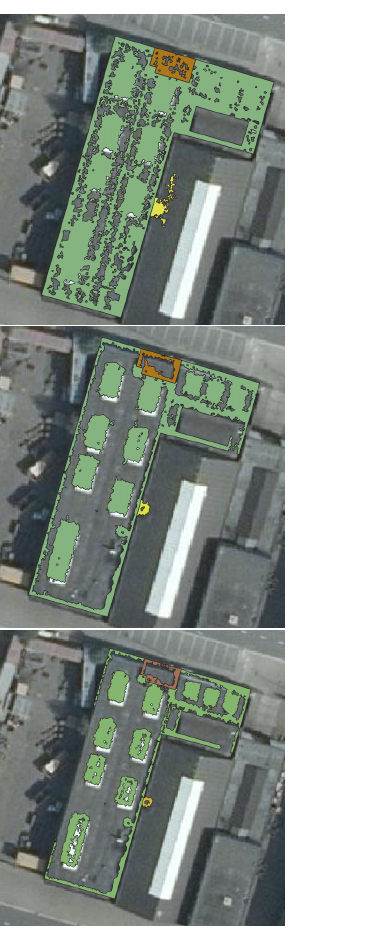
Figure 12. Regarding the angular threshold , values of 1.13 ◦ (top) lead to a clear overestimation of ‘deviations’, while at 2.56 degrees (middle), the estimation seems to be rather correct. Table 1. Error matrices (for the four setting combinations) Therefore, 2 ◦ was selected as a ‘strict’ setting. At 5.73 ◦ (bottom), showing the results of the sensibility analysis using nominal data clear holes can be recognized inside geometries. Therefore, and the cell as a unit of measurement 5 ◦ were selected as a ‘loose’ setting.